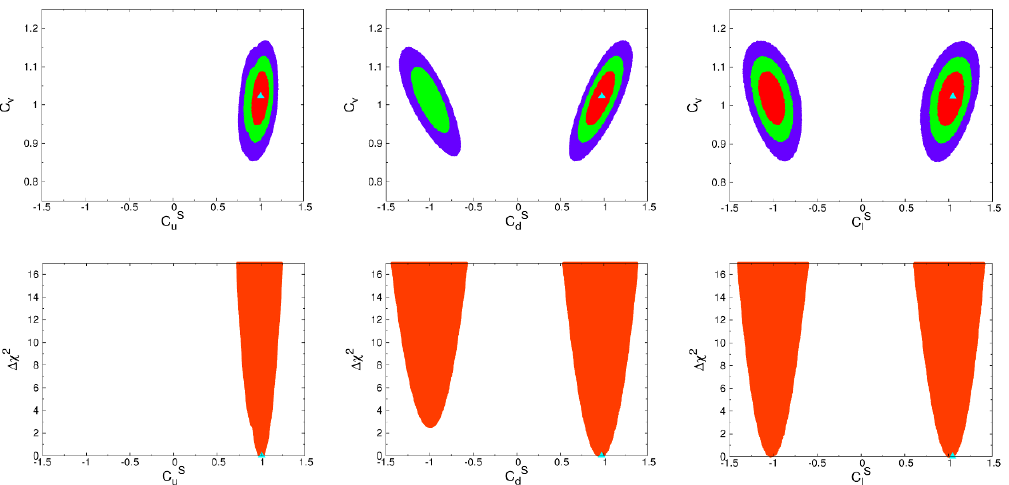
Figure 4 . CPC4 : (Upper) The con(cid:12)dence-level regions of the (cid:12)t by varying C v , C S The color code is the same as (cid:12)gure 2. (Lower) (cid:1) (cid:31) 2 from the minimum versus Yukawa couplings.